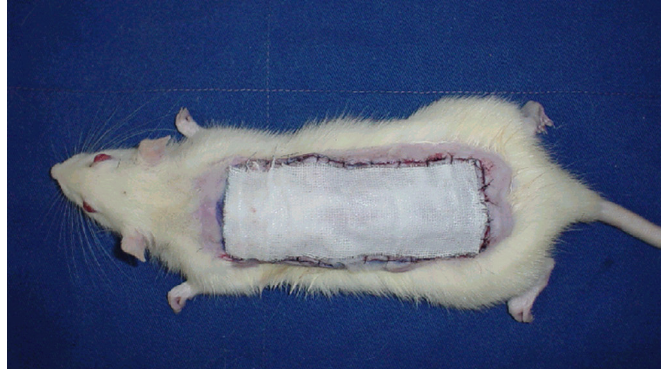
FIGURE 1 - Rayon bandage containing capsaicin or inert vehicle placed on the skin flap